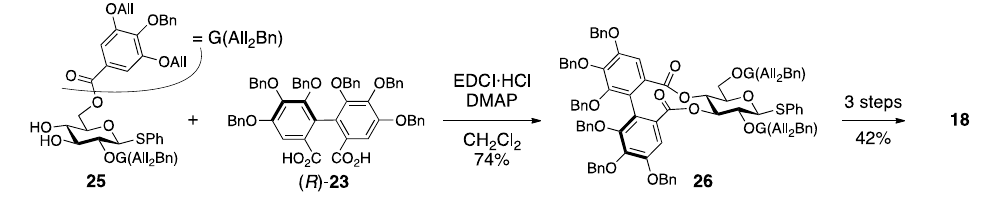
Figure 13. The key steps in the synthesis of 18 .